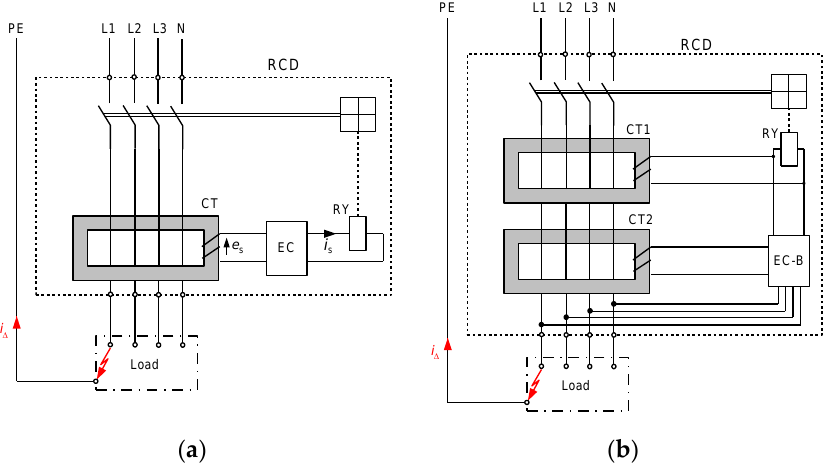
Figure 1. Structure of residual current devices (RCDs): ( a ) voltage-independent (AC-type, A-type, F-type); ( b ) voltage-dependent (B-type); RCD—residual current device; CT, CT1, CT2—current transformers; EC—electronic matching system (e.g., to increase the sensitivity to the DC pulsating waveform); EC-B—electronic system which ensures tripping especially in the case of the smooth DC residual current;